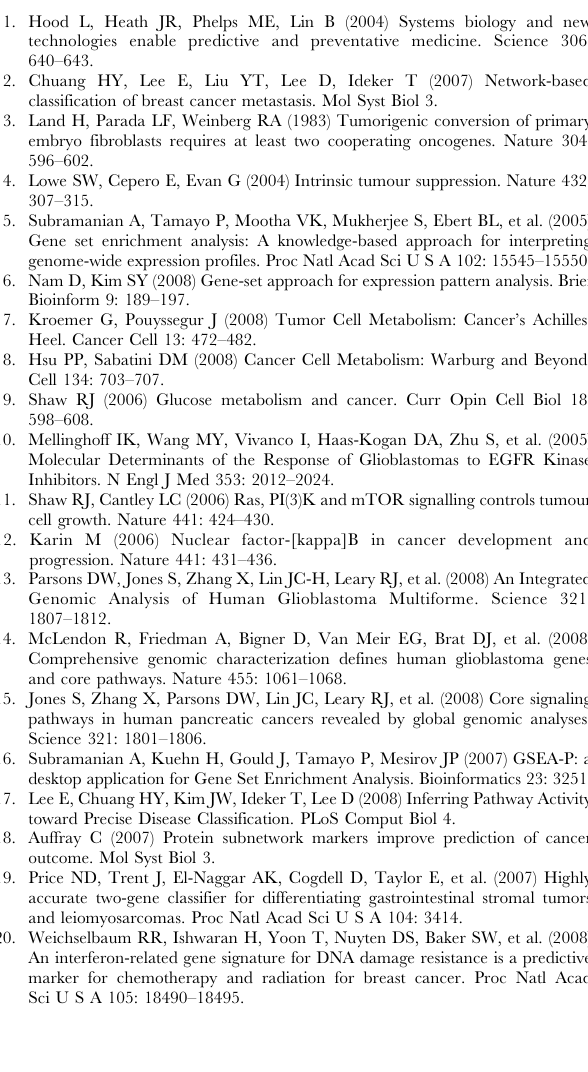
Table S1 Increasing network completeness with NCBI gene name information. Found at: doi:10.1371/journal.pcbi.1000792.s001 (0.01 MB